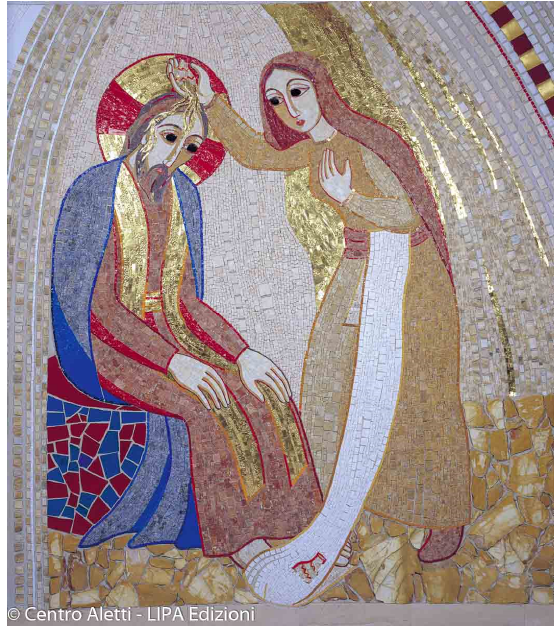
Figure 1. “Unzione di Betania” (Anointing of Bethany), Chapel of the “Casa Incontri Cristiani” (House of Christian Encounter), Capiago, Italy, 2006, by the Atelier d’Arte e e Architettura del Cen- tro Aletti (www.centroaletti.com). Accessed 15 July 2021. Used with